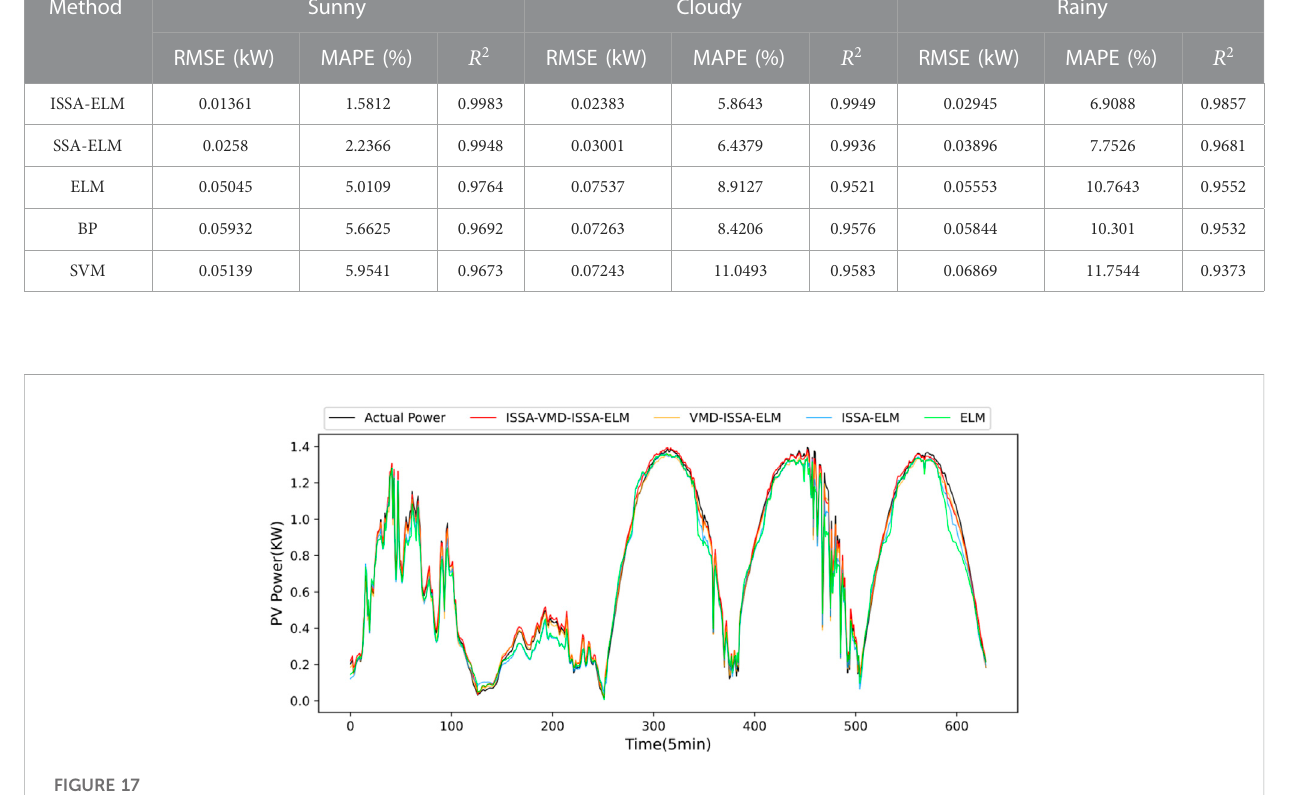
TABLE 5 Evaluation indexes of different models in three kinds of weather. Method